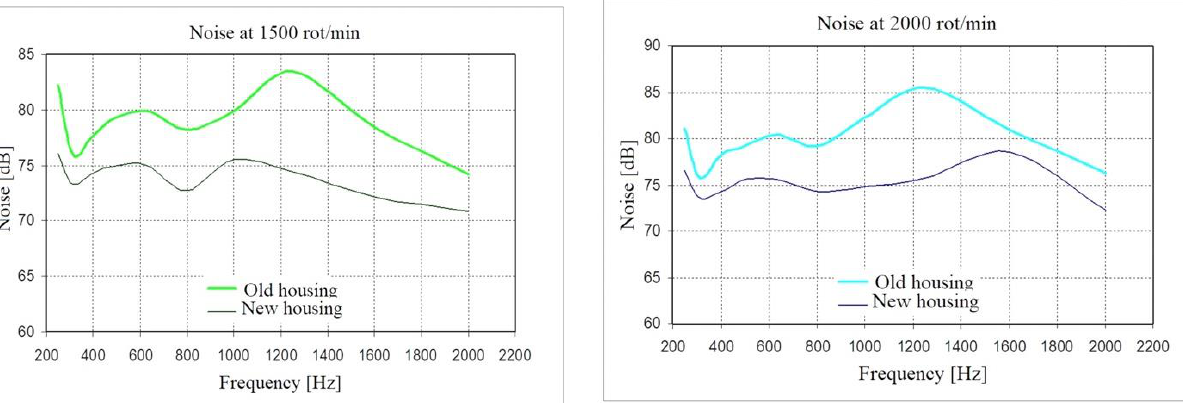
Figure 35. Lp sound pressure level diagrams for left side surface at 1500 and 2000 rpm.